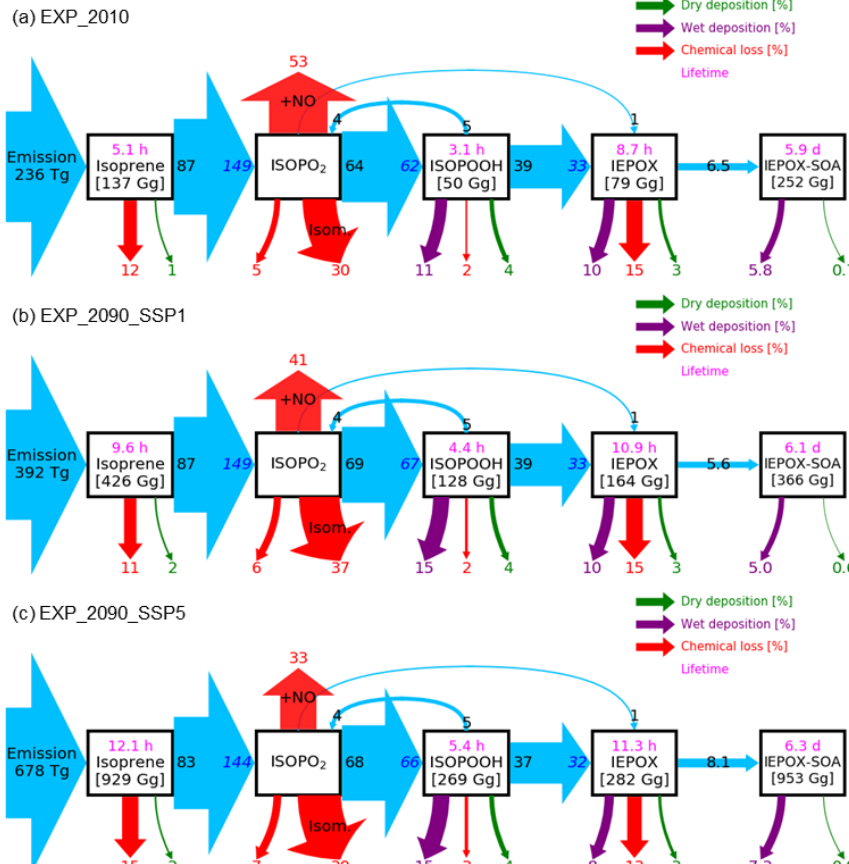
Figure 6. Relative mass flux diagrams for global IEPOX SOA budget analysis in CESM2.1.0. Blue arrows represent the IEPOX SOA formation pathway. Mass fluxes (%) are calculated relative to isoprene emissions for each scenario (i.e., normalized to the isoprene emissions) and shown outside the boxes. Absolute values of mass fluxes (Tgyr − 1 ) are presented in Fig. S14. Burdens (in Gg) are shown inside. Two flux numbers are shown if the loss amount of reactant (black number) differs from the production amount of product (blue number), which is caused by the different molecular weights and product yields. IEPOX formation initiated from the isoprene + NO 3 reaction is not explicitly shown, and its amount is added to the IEPOX formation from the ISOPO 2 + NO pathway. Red arrows show the chemical pathways not leading to IEPOX SOA formation. For the isoprene peroxy radical (ISOPO 2 ), the chemical loss is separated into three categories: the reaction with NO( + NO), isomerization (Isom.), and others. Purple and green arrows indicate wet and dry depositions, respectively. Global tropospheric burdens are shown in brackets for transported species in the model. Lifetime is shown in